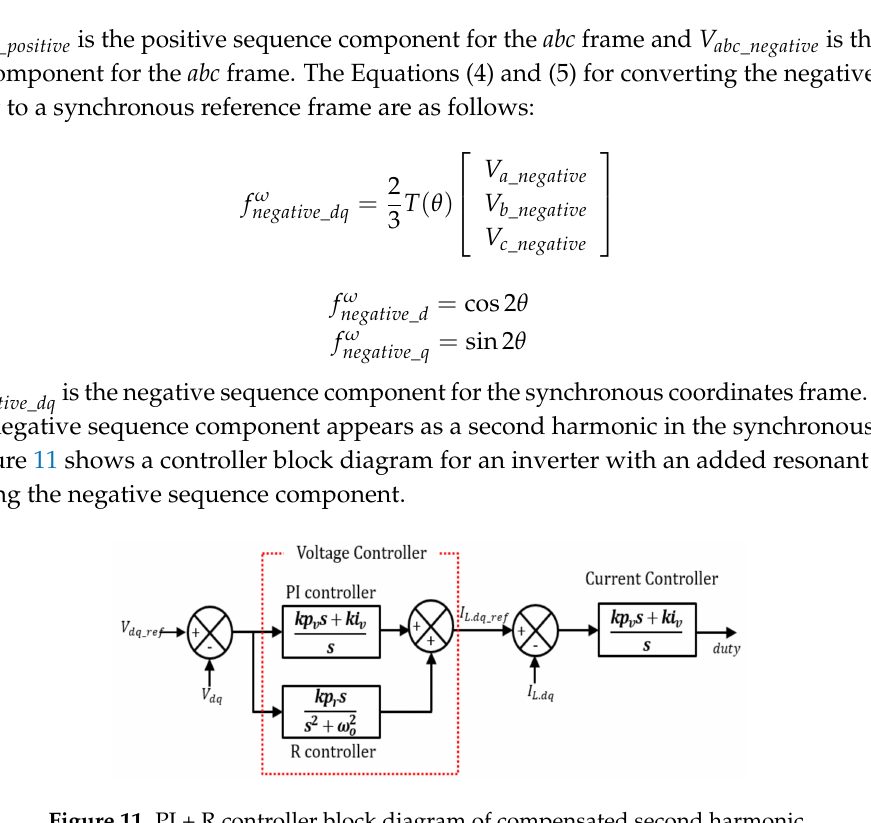
Figure 11. PI + R controller block diagram of compensated second